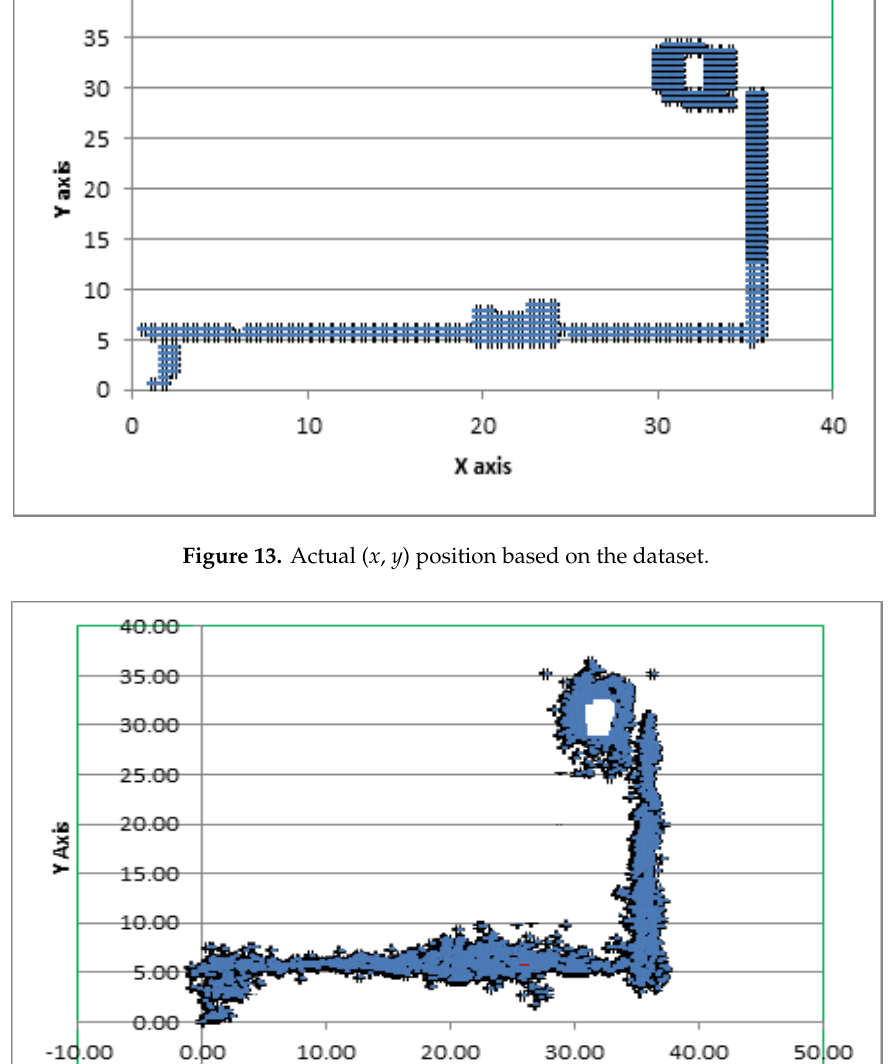
Figure 12. The best-suited regression-based deep neural network MLP model.